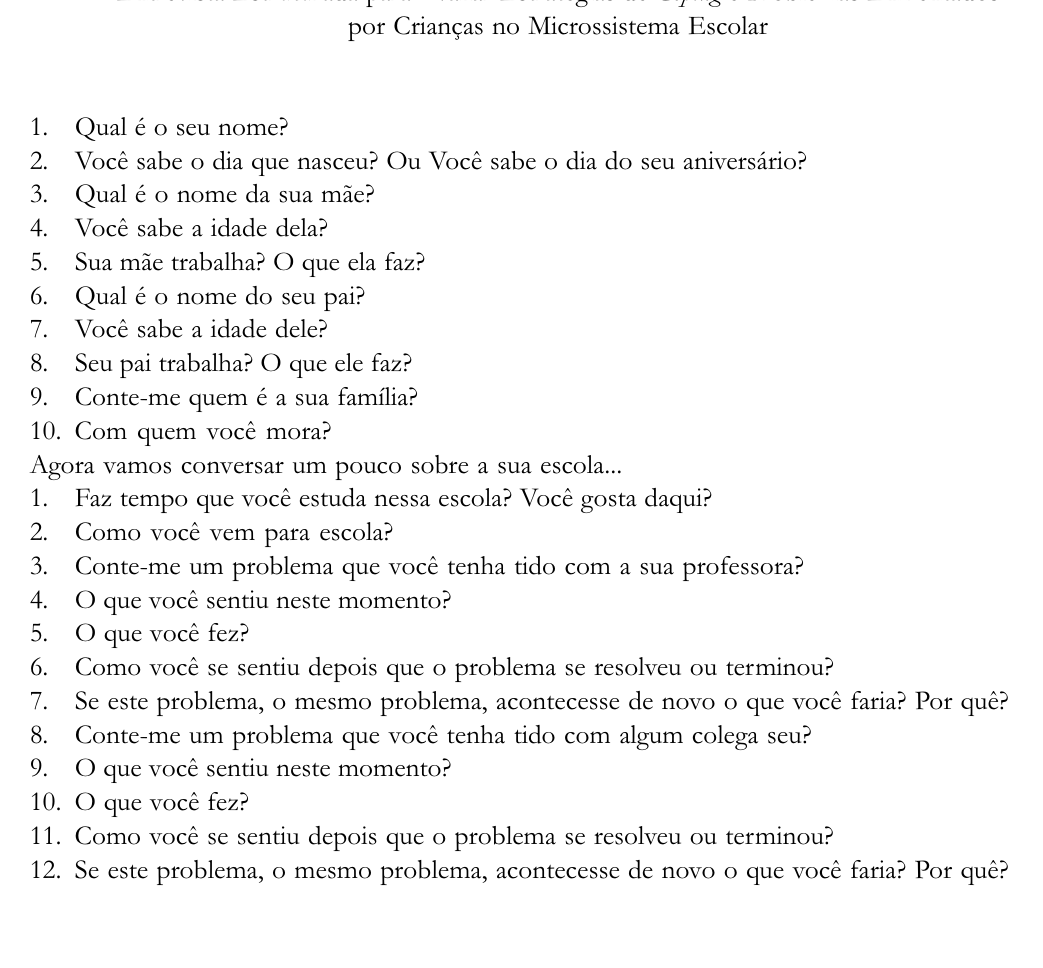
Psicologia: Reflexªo e Cr(cid:237)tica, 2002, 15(2), pp.